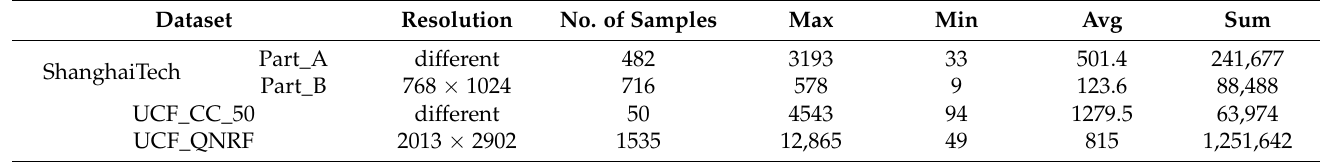
Table 1. Details of ShanghaiTech, UCF_CC_50, and UCF_QNRF